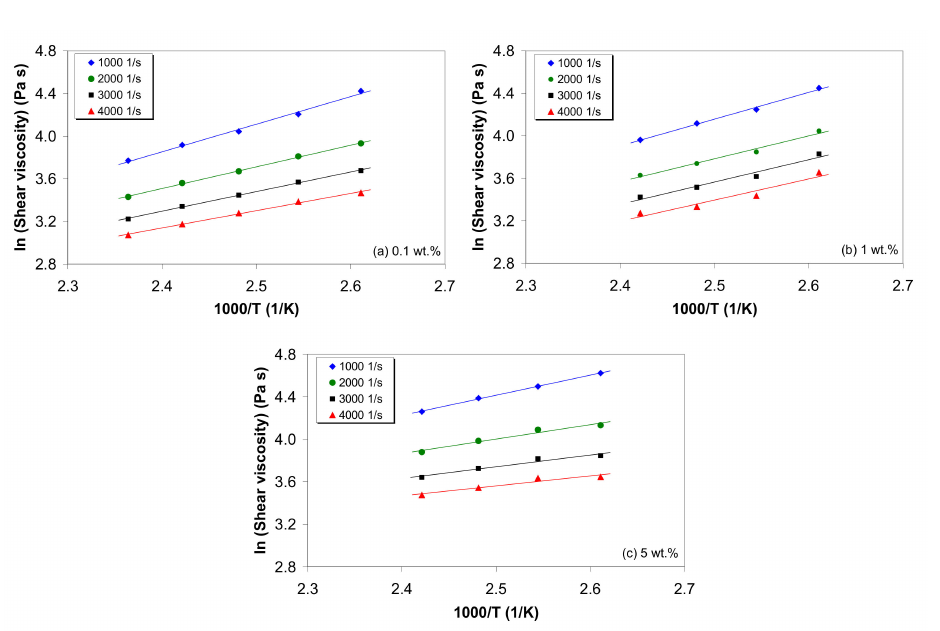
Figure 5. Arrhenius plots for the melt shear viscosity of LDPE / MWCNT composites with ( a ) 0.1 wt.%, ( b ) 1 wt.% and ( c ) 5 wt.% of MWCNTs at di ff erent shear